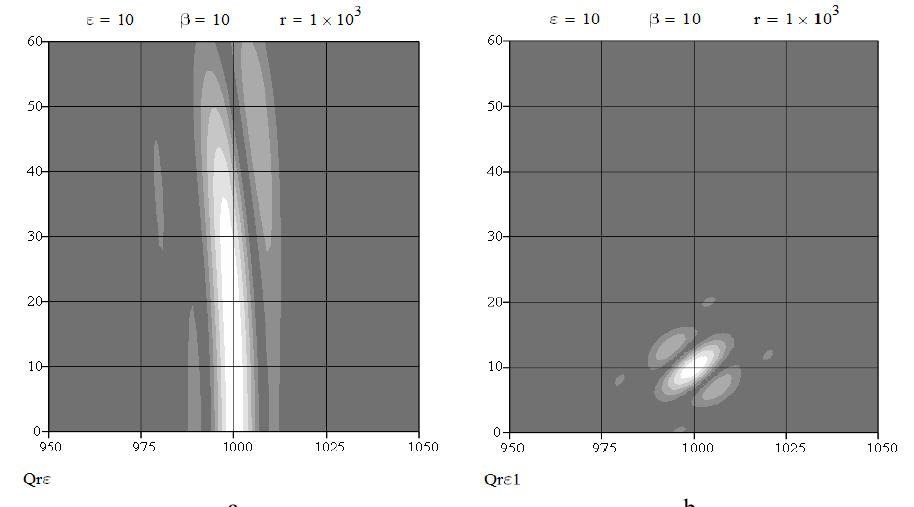
Fig. 5. Two-dimensional generalized ambiguity function cross- sections. «Azimuth — elevation» cross- section is shown in (a) and «range — elevation» cross -section is shown in (b) for (II) coordinate system type and target coordinates are